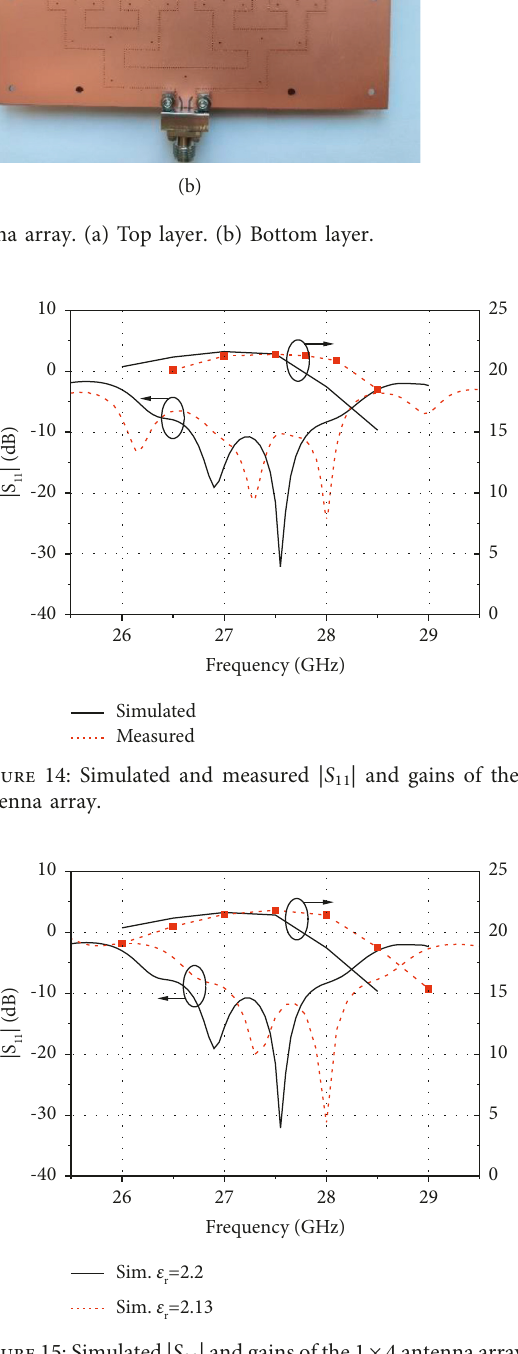
Figure 15: Simulated | S × 4 antenna array with 11 | and gains of the 1 different dielectric